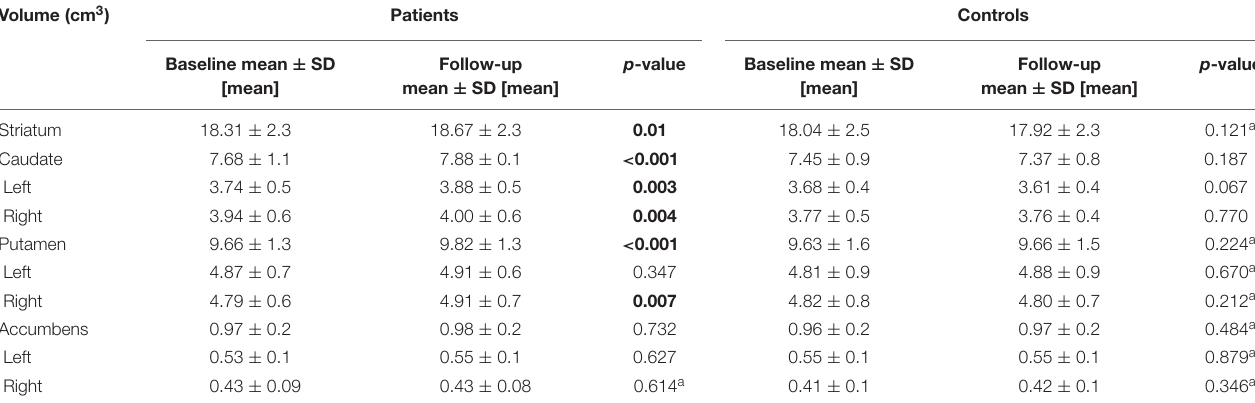
TABLE 2 | Volumes of regions of interest.